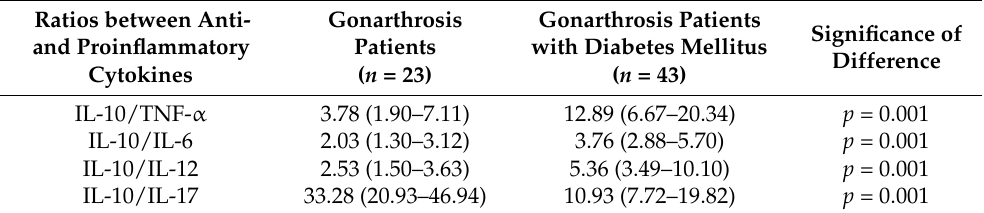
Table 3. IL-10/TNF- γ , IL-10/IL-6, IL-10/IL-12, and IL-10/IL-17 (median and interquartile range) in gonarthrosis patients with and without diabetes melitus.